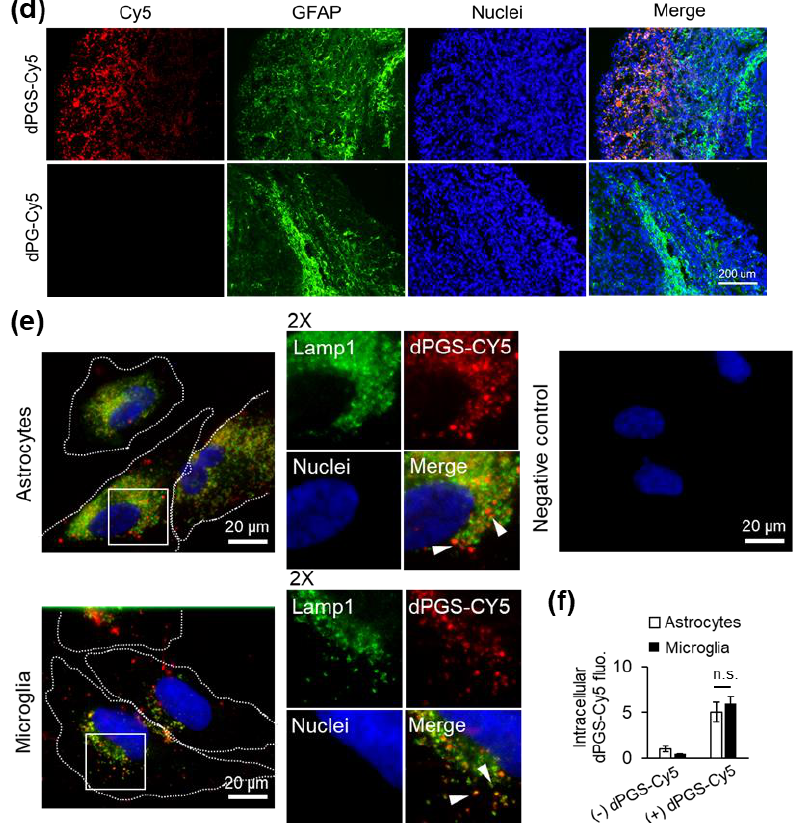
Figure 1. ( a ) Schematic representation of cerebral organoid usage for nanostructure screening. ( b ) Human cerebral organoids were treated with dendritic polyglycerol (dPG)-Cy5 (1 µ M) or dendritic polyglycerol sulfate (dPGS)-Cy5 (1 µ M) for 1 h, 4 h or 24 h. Nuclei were labeled with Hoechst 33342. Organoids were imaged using a fluorescence microscope. ( c ) Cy5 fluorescence in organoids was analyzed in ImageJ. Shown are the average fluorescence per condition ± SEM. At least 90 organoids were analyzed from three independent experiments. *** p < 0.001 ( d ) Fluorescence micrographs of human cerebral organoids treated with dPG-Cy5 (1 µ M) or dPGS-Cy5 (1 µ M) for 24 h and labeled for glial fibrillary acidic protein (GFAP). Nuclei were labeled with Hoechst 33342. ( e ) Primary human astrocytes and human HMC3 microglia internalization of dPGS-Cy5 (1 µ M) after 24 h. dPGS-Cy5 (red) is partially co-localized with Lamp1-labeled lysosomal compartments (green). The negative control was prepared in the absence of dPGS-Cy5 and primary antibody to account for background fluorescence. Nuclei were labeled with Hoechst 33342 (blue). Cells were imaged using a fluorescence microscope. ( f ) Shown are the average intracellular Cy5 fluorescence per cell expressed as fold change from untreated cells ± SD. At least 90 cells were analyzed in two independent experiments. n.s.